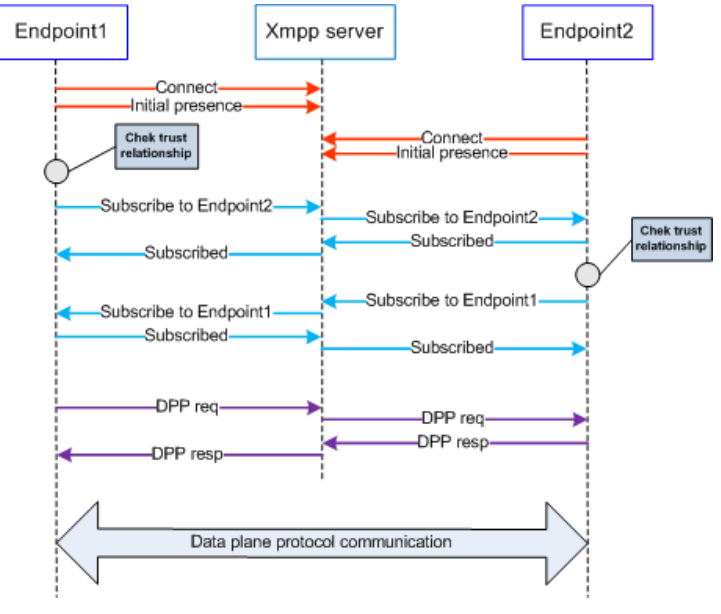
Figure 17. Data plane negotiation procedure.